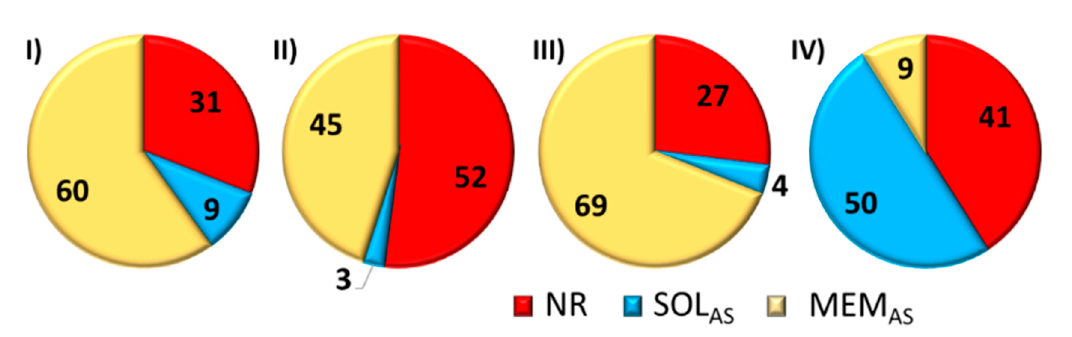
Figure 3. Graph of percentage amount of substance not released (NR), a substance released that passed through the membrane into solution (SOL AS ), and amount of substance released that remained on the membrane (MEM AS ).